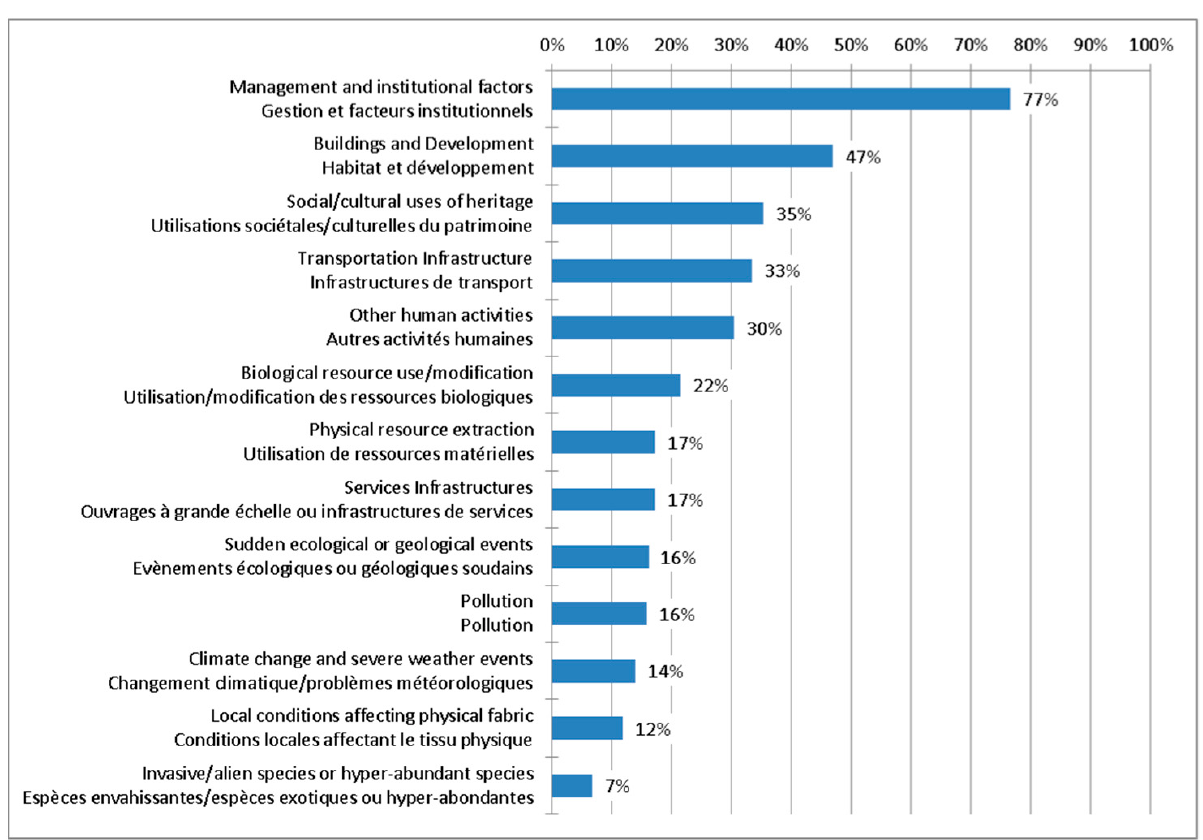
Figure 1. State of the Conservation Information System Report (UNESCO) [11].